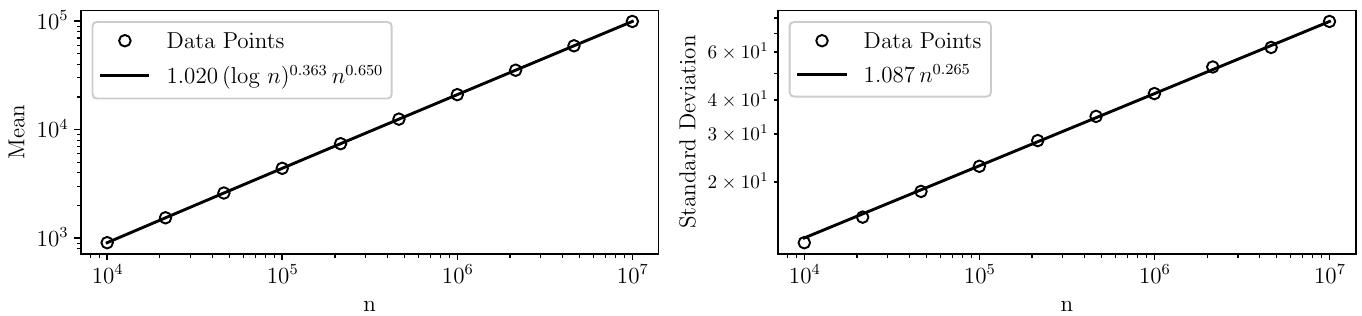
Figure 5: Log-Log plots of the best fits for the mean and standard deviation of the number of particles in model-III. The data